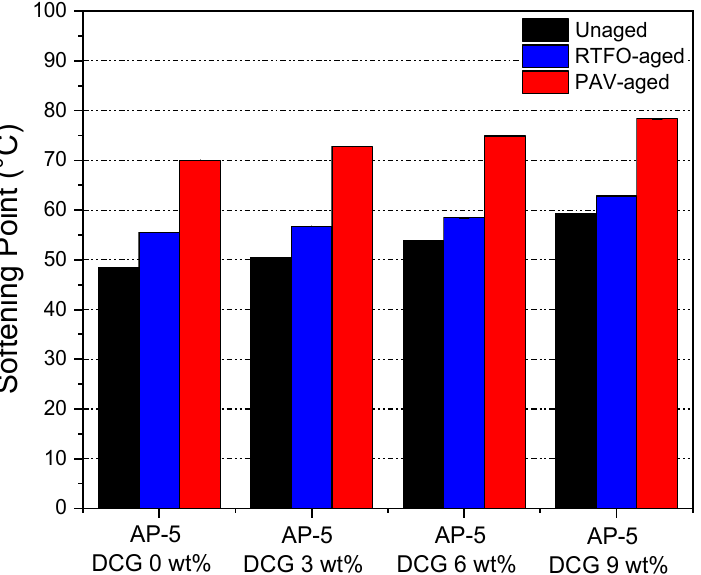
Figure 8. Impact of various dosages (e.g., 3, 6, 9 wt%) on the softening point of base AP-5 asphalt before and after RTFO and PAV aging.